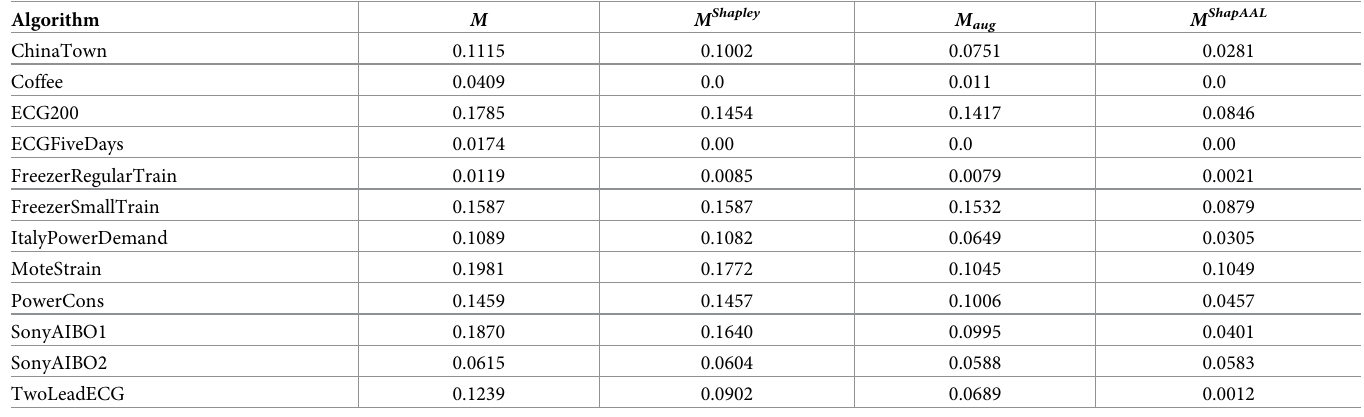
Table 4. Ablation study through MPCE of ShapAAL model ( M ShapAAL ) with M , M Shapley , M aug .